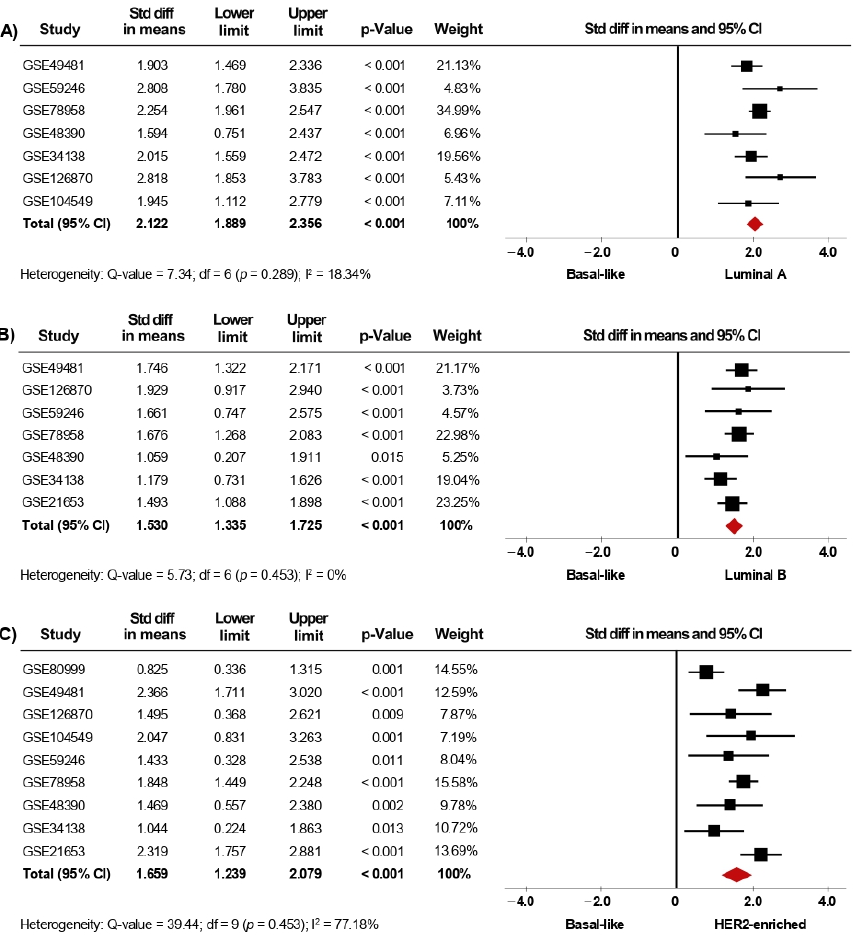
represent the SMD for each dataset. The horizontal line crossing the square represents the 95% CI. The red diamonds represent the estimated overall effect.